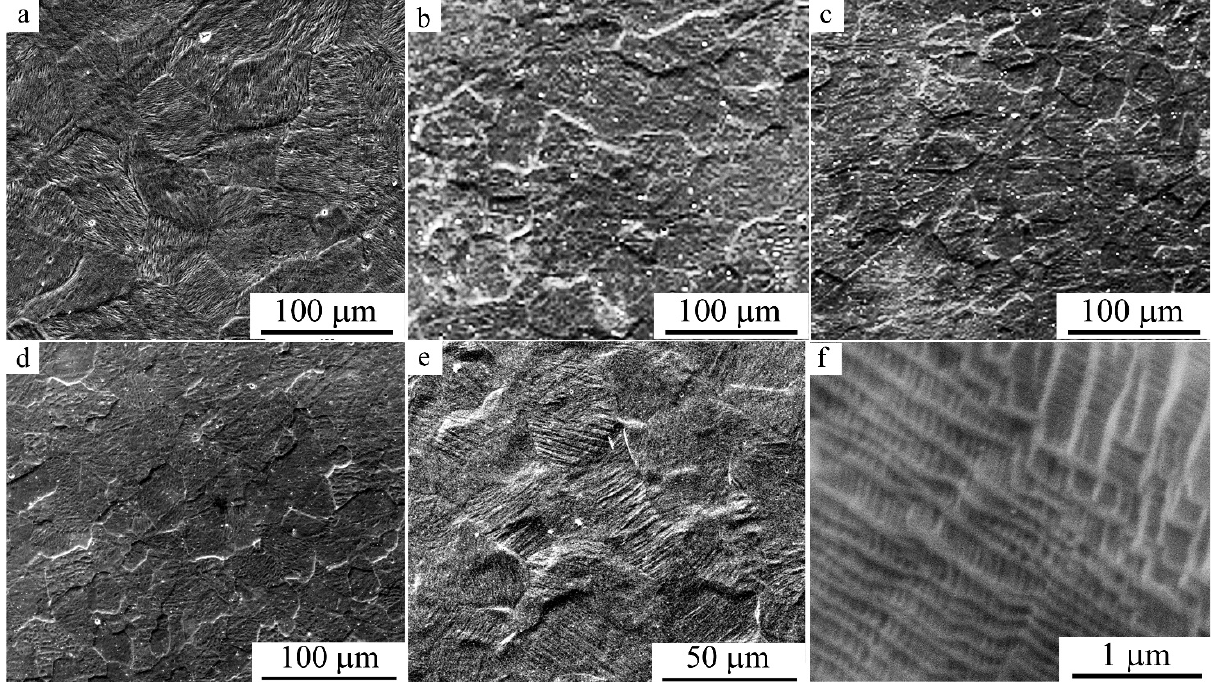
Figure 1. SEM images of the B 19’ martensite in ( a ) Ti 49.8 Ni 50.2 and B 2-austenite in ( b ) Ti 49.5 Ni 50.5 , ( c ) Ti 49 Ni 51 , and ( d ) Ti 49.4 Ni 50.6 quenched alloys, and also baro-induced B19’-martensite in ( e , f ) Ti 49.4 Ni 50.6 after treatment with a pressure of 6 GPa at RT [80].